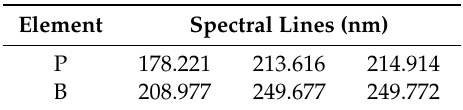
Table 2. Spectral lines employed for ICP-AES